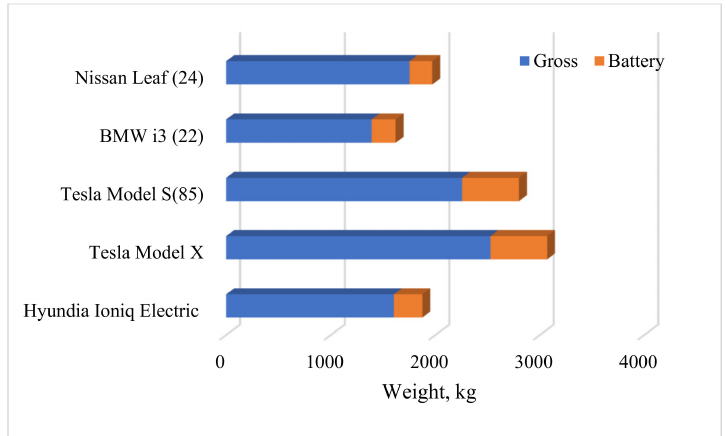
Figure 2. Weights of some EVs and their battery